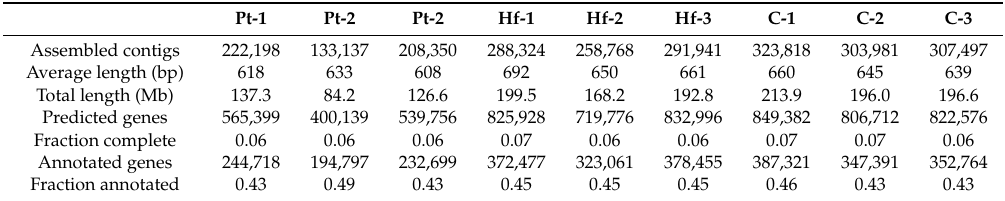
Table 2. Summary of metagenome assembly, gene prediction, and